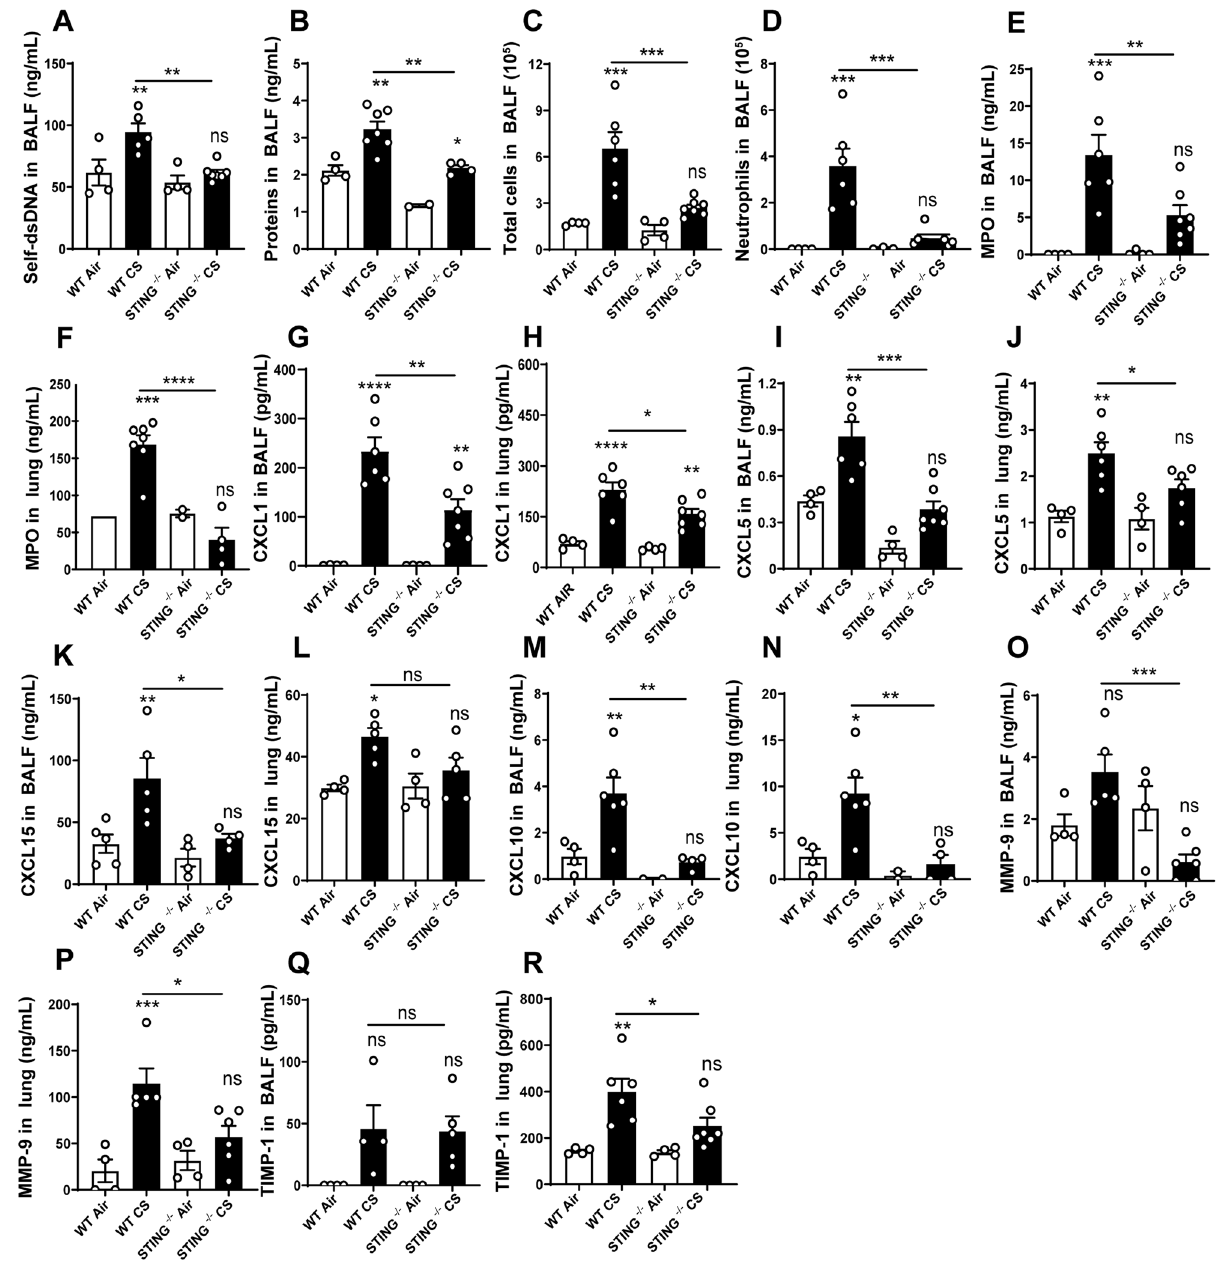
Figure 3. Cell recruitment induced by CS-exposure is decreased in STING − / − mice. Self-dsDNA ( A ) and protein levels ( B ) were measured in BALF. Total cells ( C ), neutrophils ( D ), MPO level in BALF ( E ) and lung ( F ) are shown. The level of CXCL1 ( G , H ), CXCL5 ( I , J) , CXCL15 ( K , L) and CXCL10 ( M , N) respectively in BALF and lung are shown. Remodeling factors MMP-9 ( O,P ) and TIMP-1 ( Q,R ) were measured respectively in BALF and lung are shown. Bar graph are expressed ±